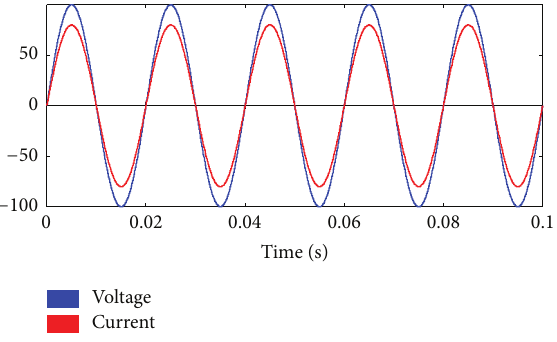
Figure 6: Effort and flow variables